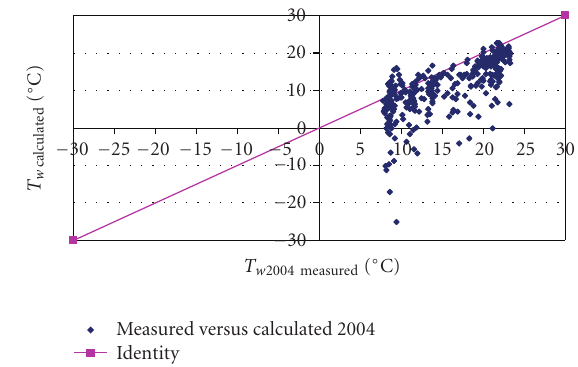
Figure 17: Comparison between measured and estimated data (11), correlation coe ffi cient r Tw , Tw 1 = 0 . 6744.